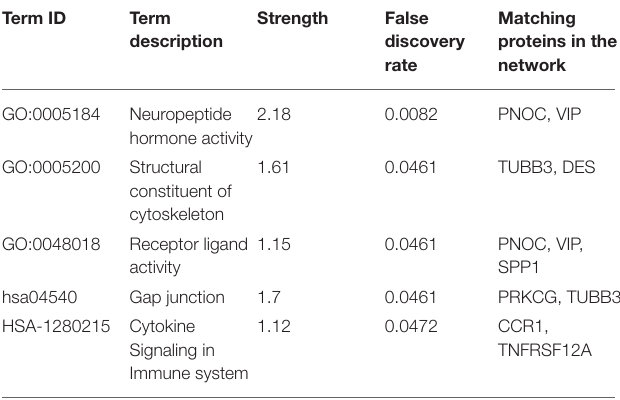
TABLE 2 | Enrichment analysis of genes in the